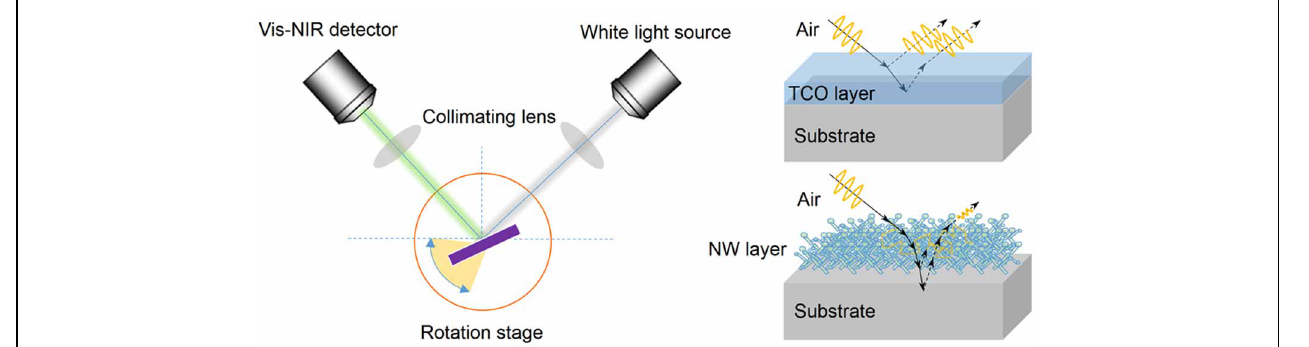
and absorption at certain wavelengths allows a suppression of the reflections from the substrate interface that cannot interfere with the remnant intensity of light that reflects within the output light cone. The rough, graded index top surface enhances absorption and aids in broadband antireflection.